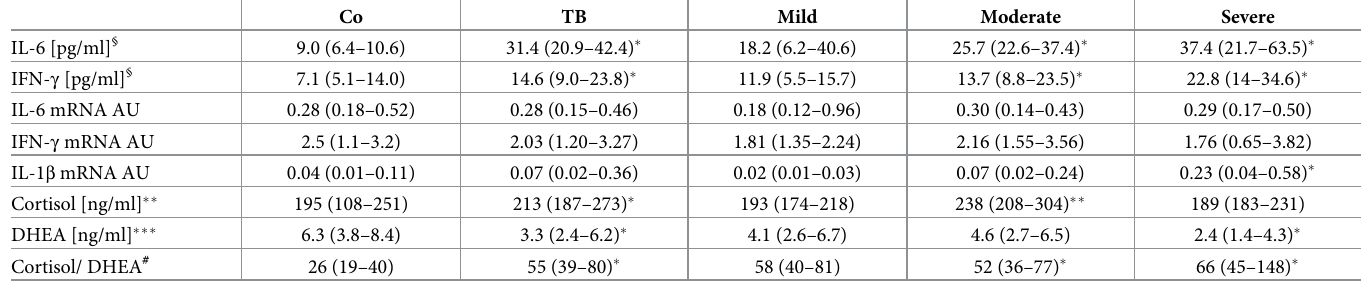
Table 5. Proinflammatory cytokines, adrenal hormones plasma levels and Cortisol/DHEA ratio together with mRNA levels for proinflammatory cytokines of PBMC from controls (Co), and patients with pulmonary tuberculosis (TB) with different degree of pulmonary involvement (mild, moderate and severe). Co TB